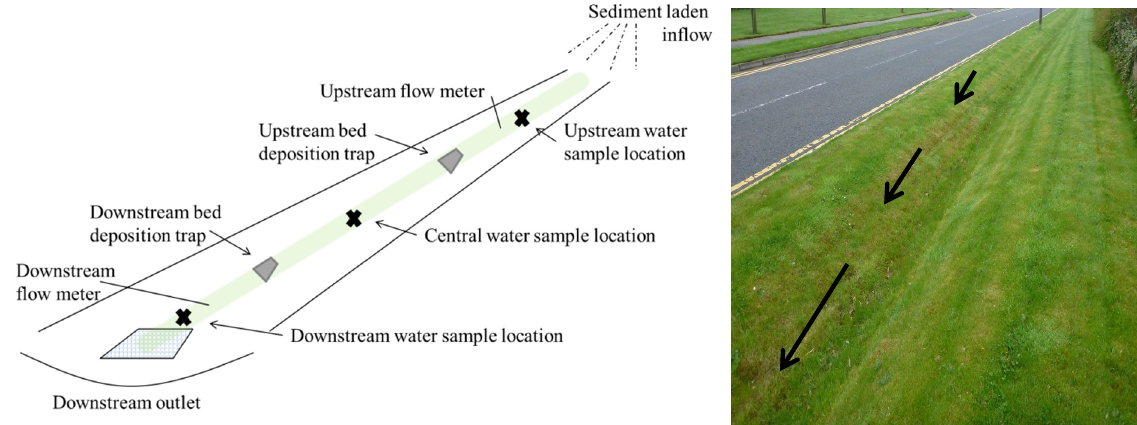
Figure 1. Schematic swale